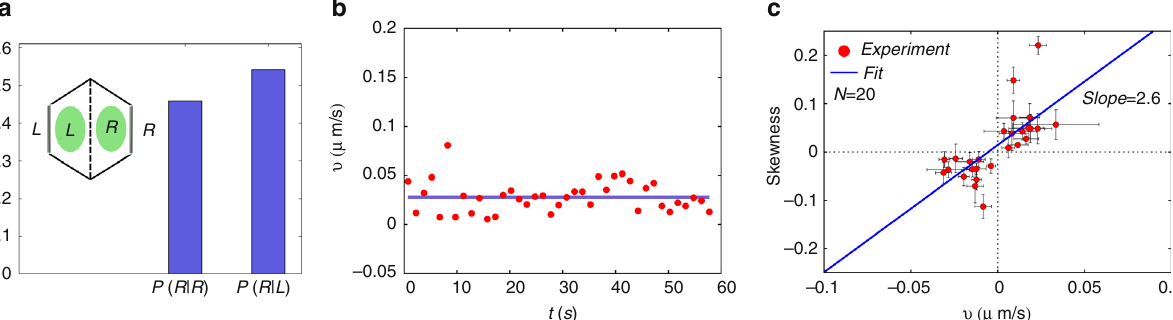
Fig. 9 Velocity and pro fi le of myosin dense regions: a Histogram of the number of fl ows that move to the right junction R starting from either the right R ( P ( R | R ) or the left L ( P ( R | L ) region of the cell (inset shows schematic). The data collected from 24 actomyosin-dense clusters over 18 cells. The fact that the histograms are similar is consistent with the theoretical prediction that the fl ow is spontaneous and not driven by the cell boundaries. b Velocity of an isolated fl owing actomyosin-dense cluster monitored over time shows that it is a constant, as predicted by theory. c Here we present average skewness values of 28 different pulses plotted against average velocities of the respective pulses. The linear behavior is quite clear from the data and a linear fi t produced a slope value of 2.6 ± 0.5. This intensity data set was prepared from 20 myosin-GFP-tagged germband cells ( N = 20). Error bars indicate s.e.m. of fl uctuation of skewness and velocity values of a pulse in